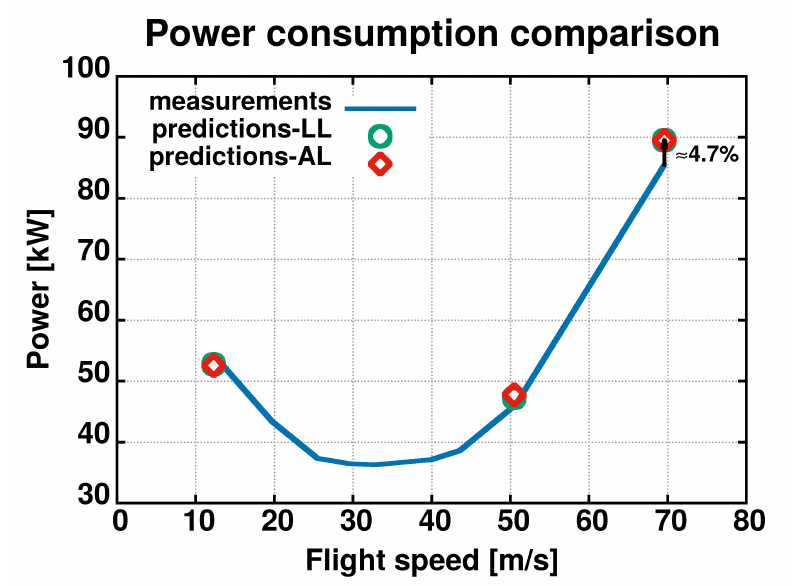
Figure 35. Rotor power requirement comparison. Simulation predictions vs experimental measure-